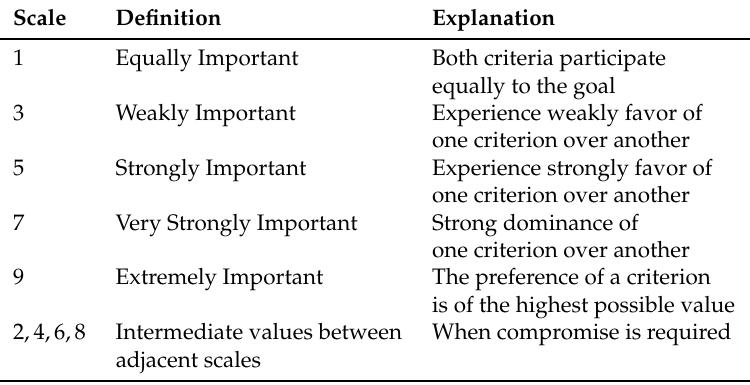
Table 1. Saaty (1–9) Preference